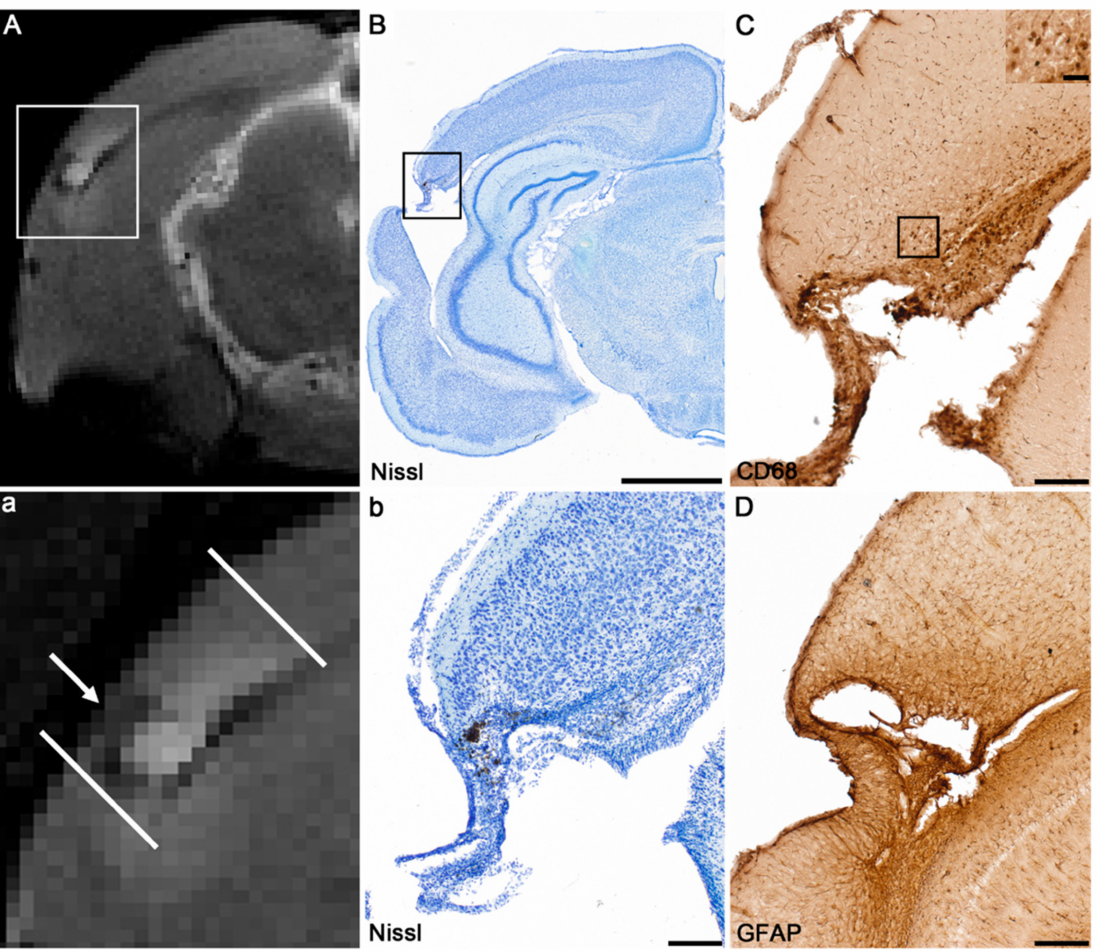
Figure 2. Assessment of chronic neuroinflammation. ( A ) Magnetic resonance imaging (MRI) was used to identify animals with a prominent increase in T2-enhancement around the lesion (arrow in a high magnification representation ( a )) indicating perilesional inflammation. ( B ) Nissl-stained sections show detailed cytoarchitectonics of the perilesional area. ( C , D ) Immunohistochemical stainings were used to confirm chronic neuroinflammation suggested by T2-enhancement. Immunohistochemical staining for CD68 (macrosialin) showed activated microglia/macrophages in the perilesional cortex (panel ( C )). Immunohistochemical staining for glial fibrillary acidic protein (GFAP) with qualitative analysis showed astrocytic fibers (panel ( D )). Scale bars = 2000 µ m ( B ), 200 µ m ( b , C , D ) and 50 µ m (insert in panel ( C